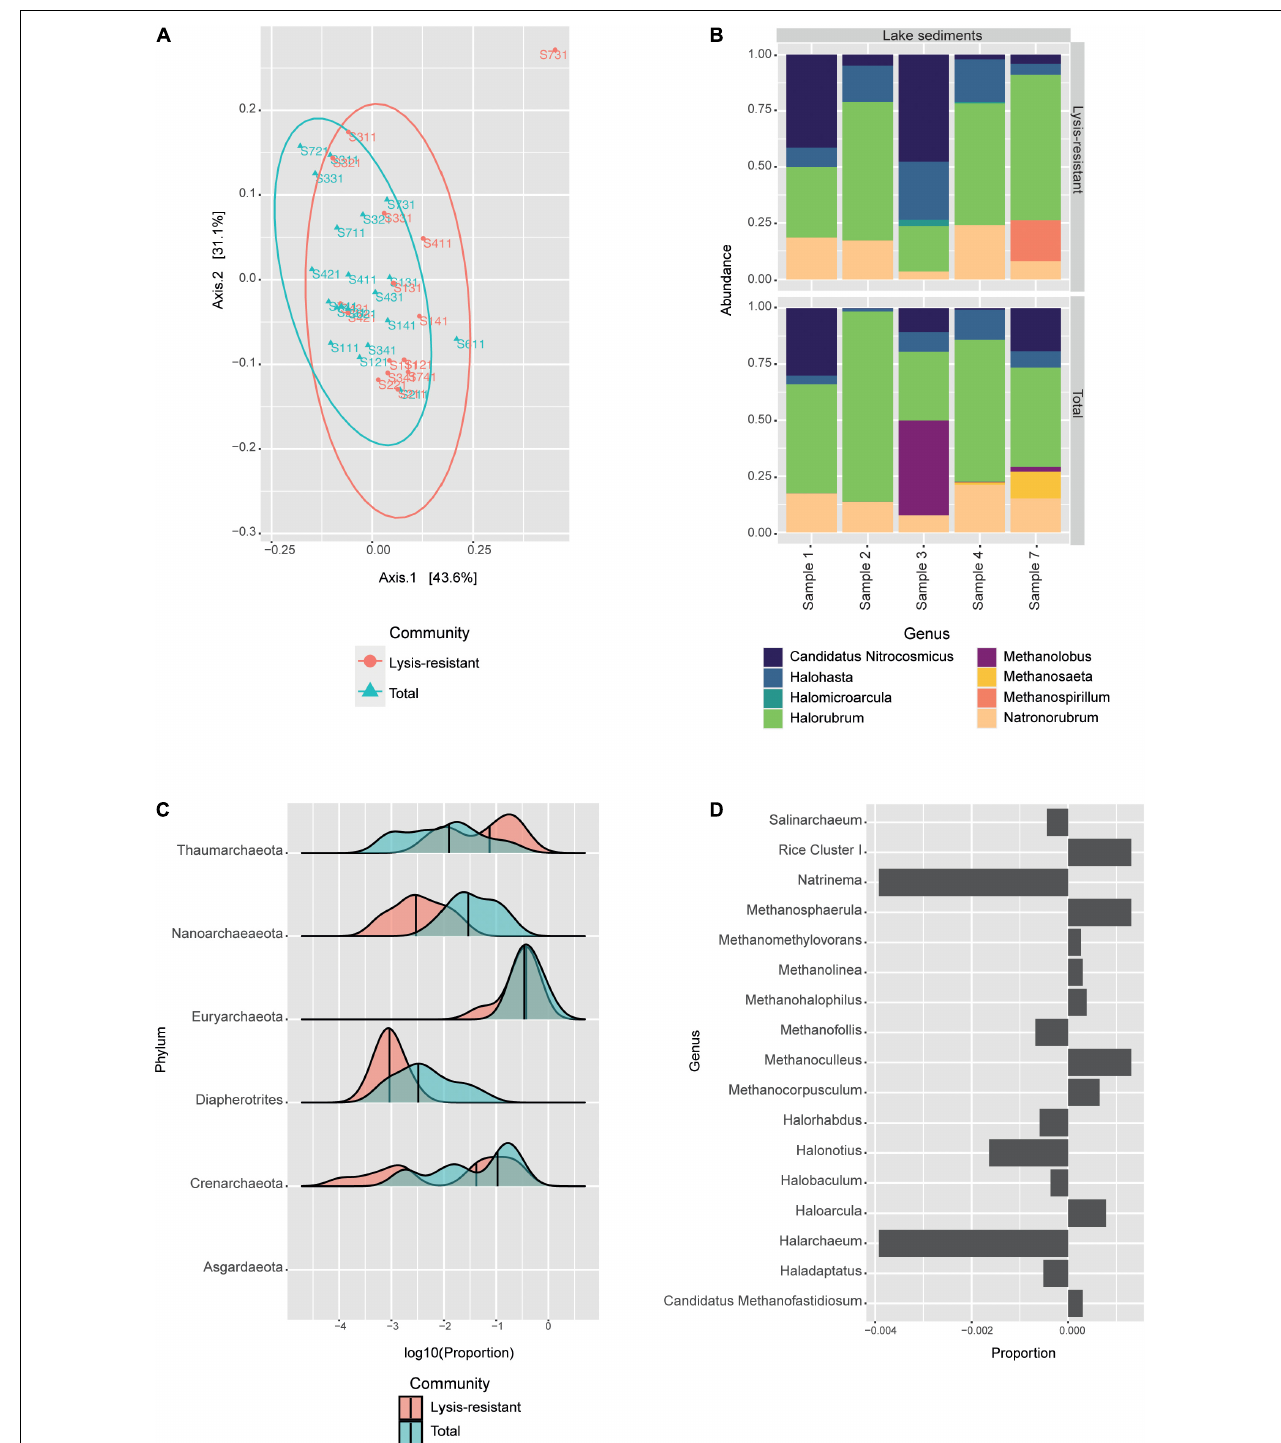
FIGURE 5 | Archaeal community in the lake sediments. (A) Weighted UniFrac PCoA of the archaeal community, belonging to the lysis-resistant fraction (red) or the total fraction (blue). The ellipses show a 95% confidence level per group. (B) Top 50 archaeal ASVs relative abundance per lake sediment core at the genus level. (C) This plot shows the abundance distribution of the different phyla, for either the lysis-resistant (red) and the total fraction (blue) in the lake sediments, the abundance is shown in log10 of the relative abundance. (D) Enrichment of Euryarchaeota in the lysis-resistant or total fraction. Negative values show enrichment in the lysis-resistant fraction, while positive values show enrichment in the total fraction. Proportion threshold at ≤ 0.00025 and > 0.00025.